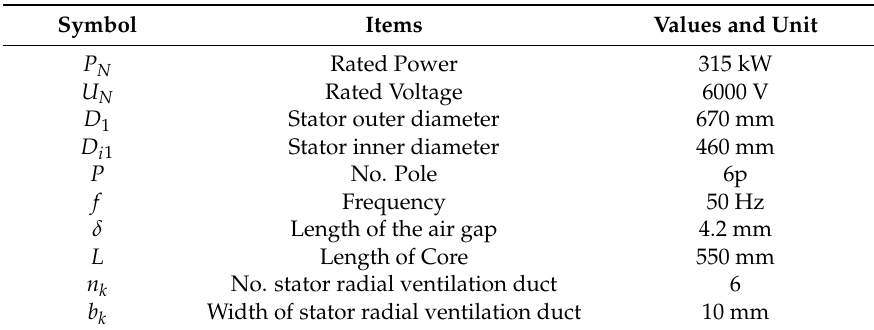
Table 1. Design parameters of High-Voltage Line-Start Solid Rotor Permanent Magnet Synchronous Motor